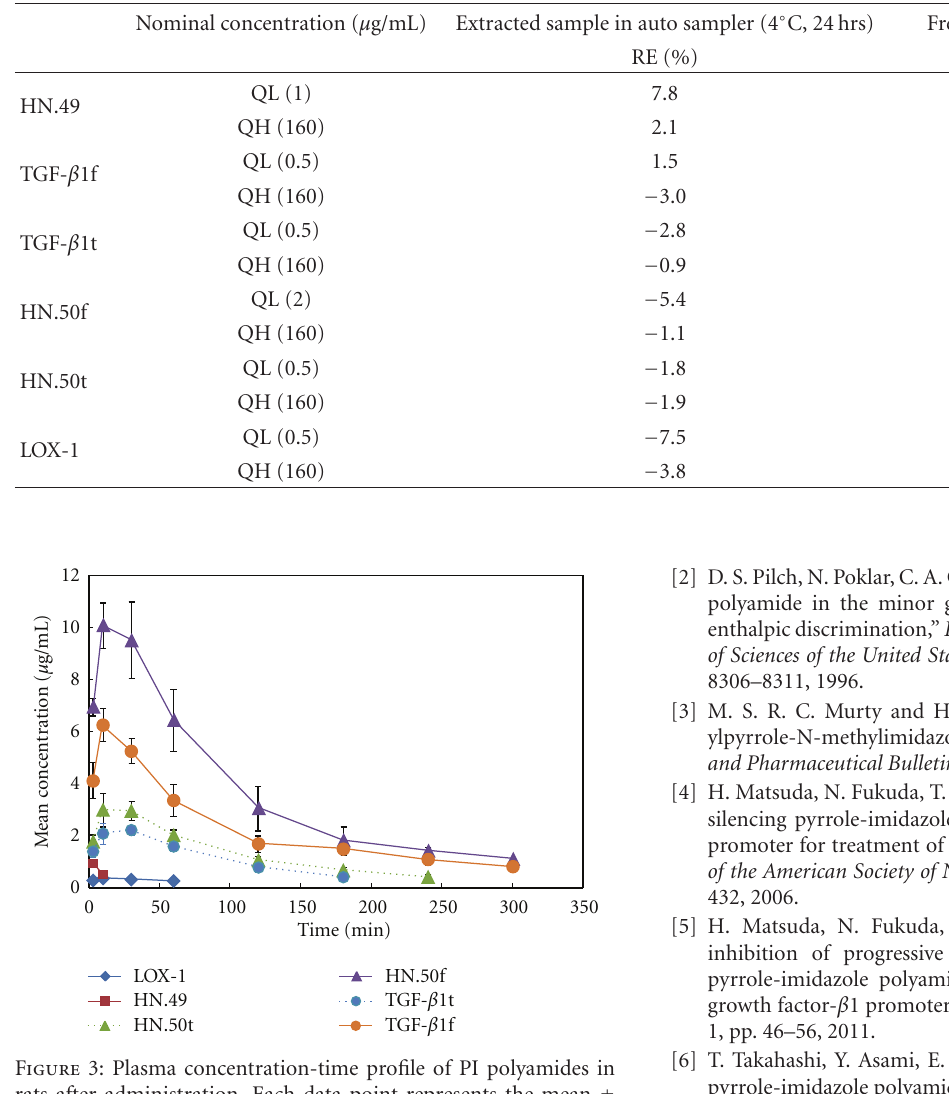
Table 4: Stability.